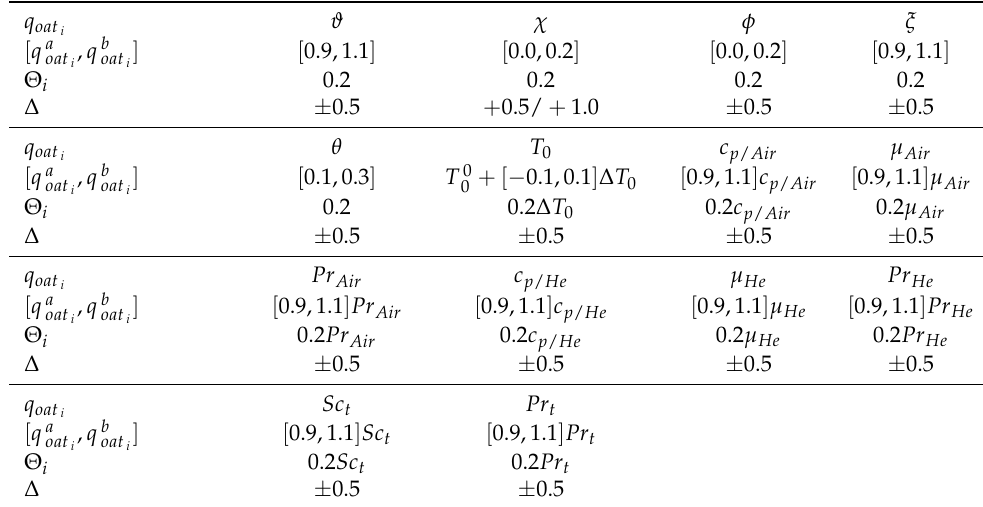
Table 1. Parameter variation values for the one-at-a-time (OAT)